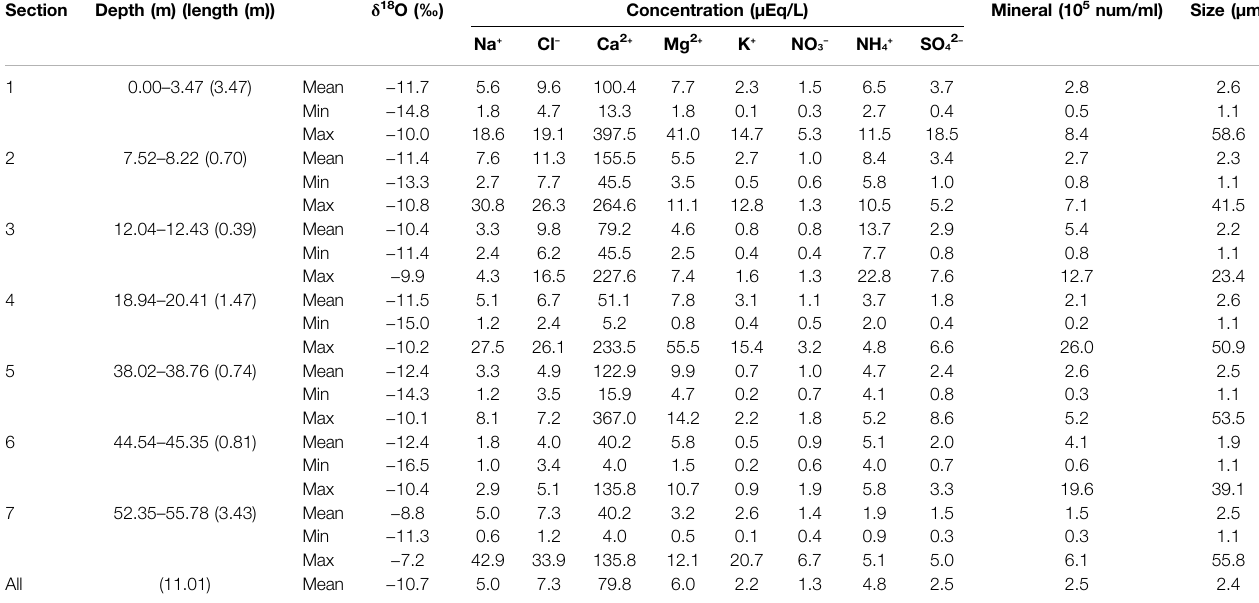
TABLE 1 | Oxygen stable isotope, concentrations of major chemical solutes and mineral dust, and size of minerals in the seven sections of Core A drilled from the ablation area of the glacier. Section Depth (m) (length (m)) δ 18 O ( ‰